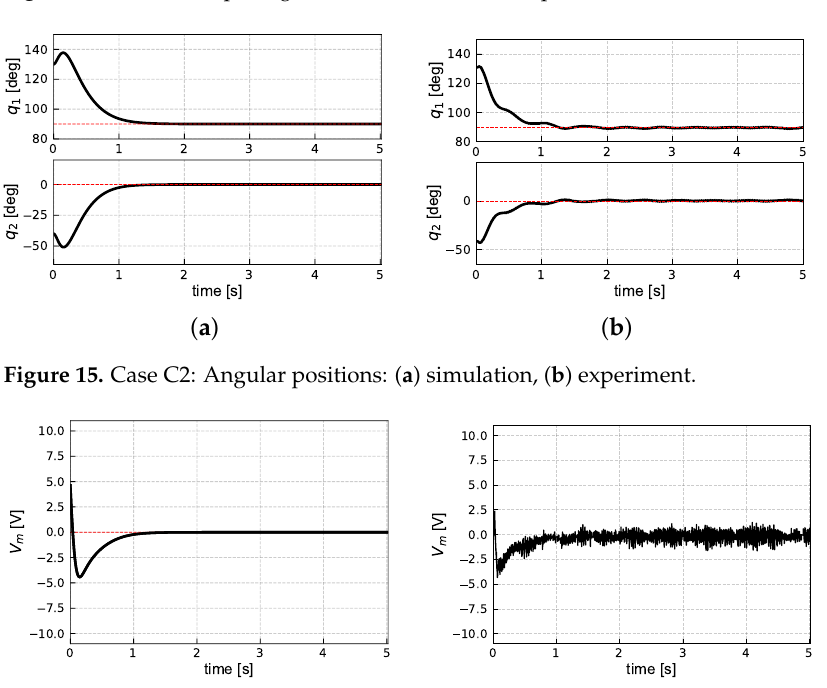
Figure 14. Case C1: Input signal: ( a ) simulation, ( b ) experiment.